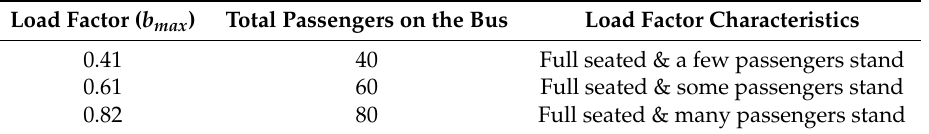
Table 1. The Relationship between the Load Factor and Total Passengers on the